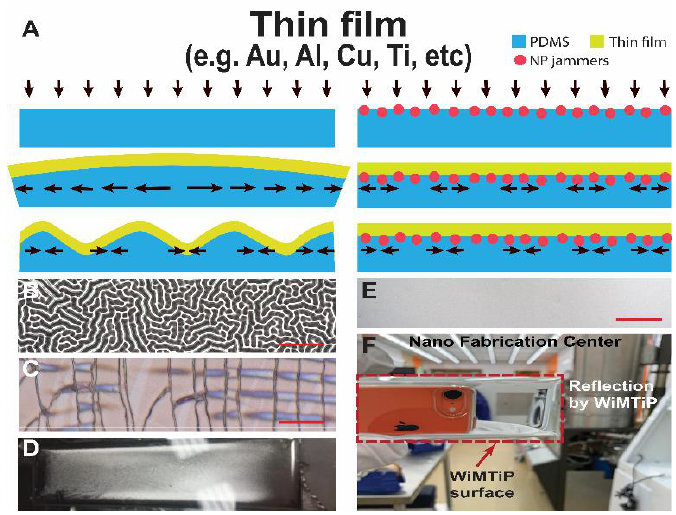
Figure 1. Principle and sample results of fabricating wrinkle-free metallic thin film in polymer (WiMTiP) using nanoparticle (NP) interfacial jamming technology. ( A ) Schematics elucidating: (Left) wrinkle formation mechanism of a thin film over an elastomer substrate by compressive stress-induced interfacial instability. (Right) wrinkle suppression mechanism using NPs to jam the interface and subsequently confine compressive stresses locally. ( B – D ) Characteristics of a 50 nm thick Al film over a 2 mm PDMS substrate without jammers. ( B ) Micrograph (10×) of wrinkles developed as the film was deposited onto the substrate. ( C ) Micrograph (10×) of fractures developed as the film pre-deposited over a wafer is transferred to the substrate. ( D ) Image of a glossy (non-reflective) sample. ( E , F ) Characteristics of a 50 nm Al in PDMS WiMTiP sample with 500 nm thick jammers. ( E ) Micrograph (10×) of smooth WiMTiP surface. ( F ) Photograph of a WiMTiP sample against cleanroom background showing a reflection of the recording camera. Scale: 20 μm .